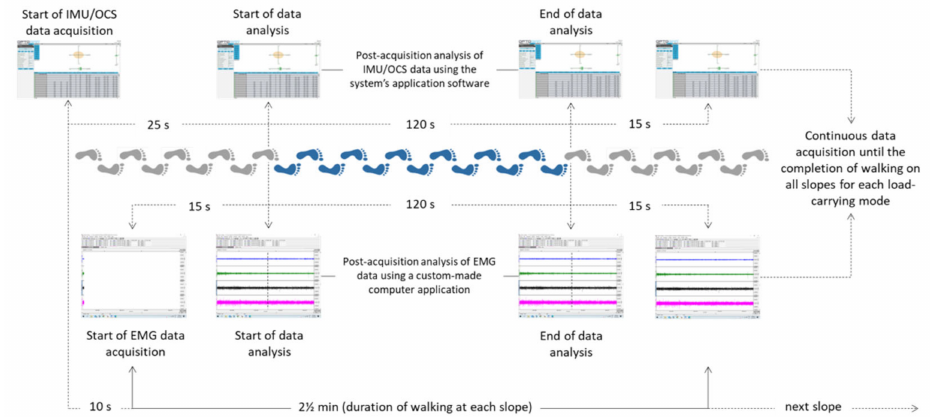
Figure 1. Graphical representation of the setup used to simultaneously acquire and record IMU/OSC and EMG data. Data acquisition, once started, continued without interruption while walking on all four slopes at all loading conditions. Post-acquisition data analysis was performed based on the number of steps performed in the intermediate 120 s of total walking duration in each